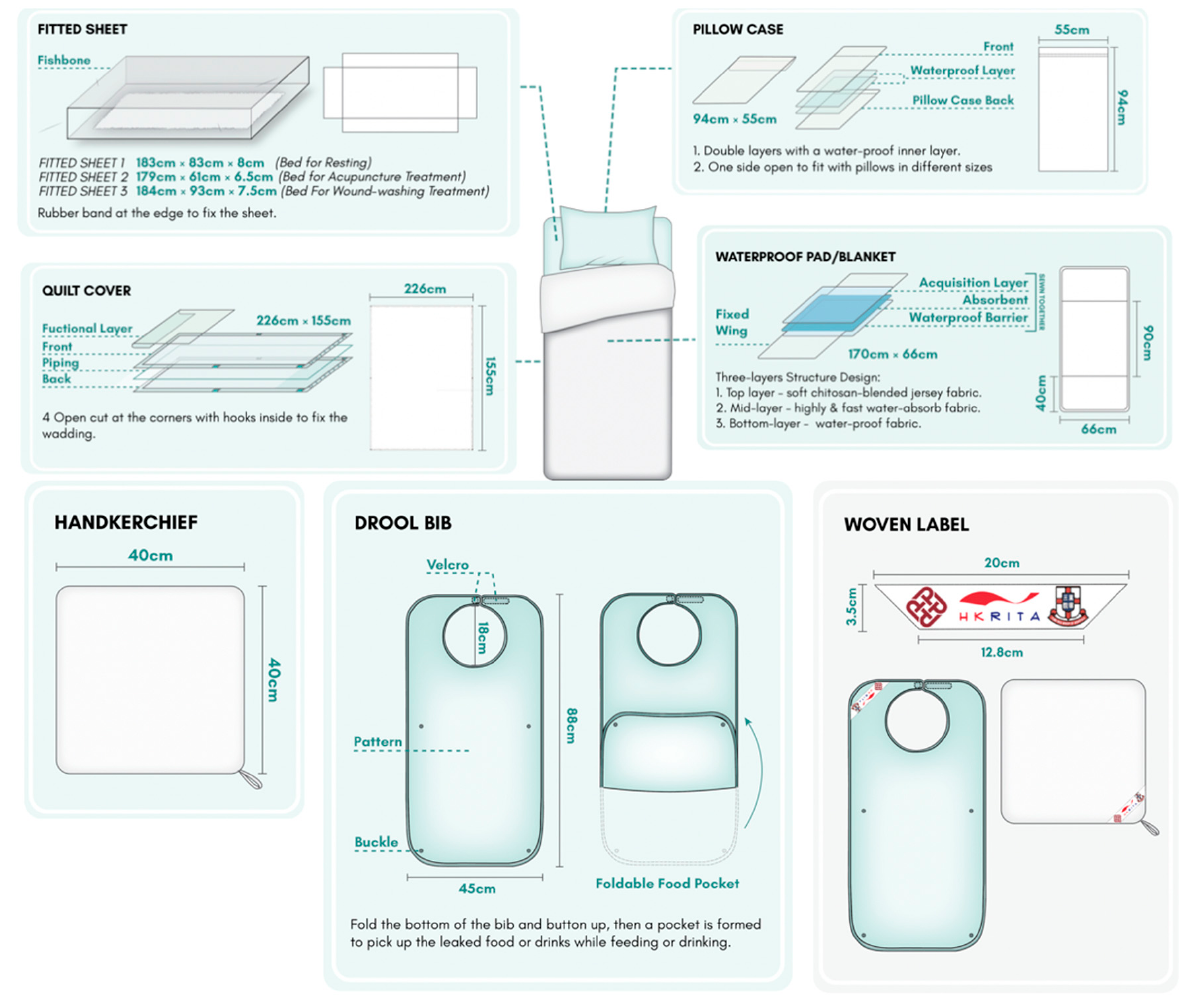
Figure 3. Basic design and sizing of the prototypes.